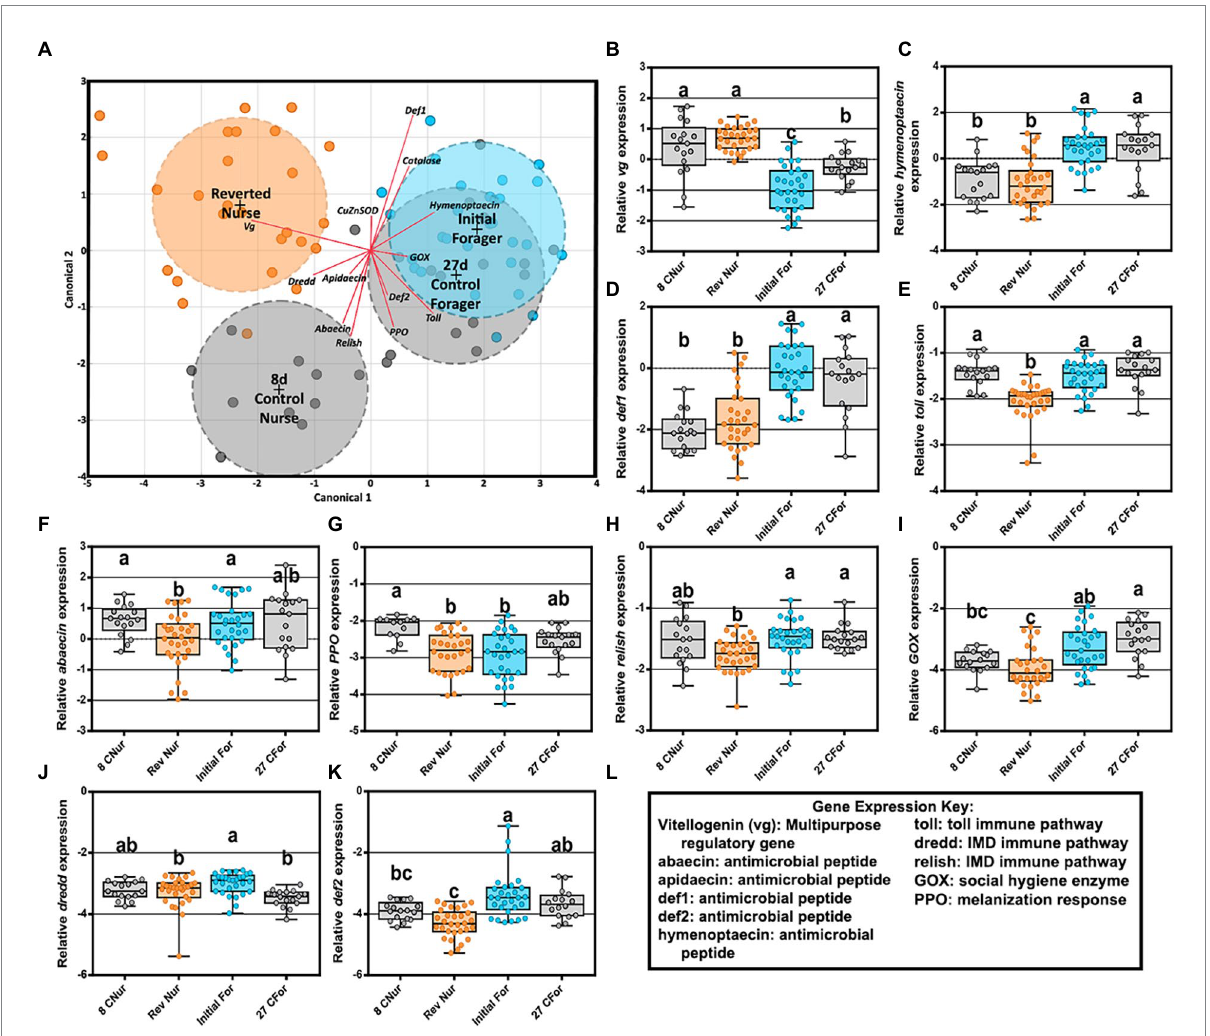
FIGURE 6 Reversion experiment gene expression comparing 8-day-old control nurses, 27-day-old control foragers, initial foragers (pre-reversion), and reverted nurses (initial foragers after 1 week of nursing) (A) Canonical correlation analysis of fat body gene expression by age and behavioral phenotype. Ellipses demarcate 95% confidence and phenotypes are displayed at the group’s centroid. (B–D) Fat body gene expression of reverted nurses was similar to that of 8-day-old control nurses. (E–K) Reverted nurse gene expression was reduced compared 8-day-old control nurses or foragers. (L) Key explaining functional roles of gene expression. Different lower case letters indicate significant differences ( p < 0.05).